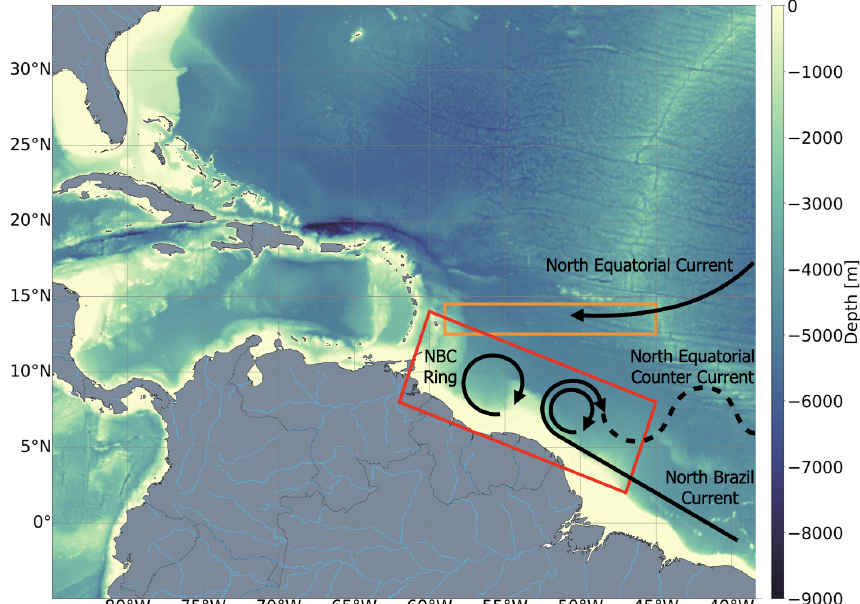
Figure 1. Bathymetric map of the northern Tropical Atlantic Ocean, with the EUREC 4 A-OA/ATOMIC regions of interest framed in orange for the trade wind alley and in red for the eddy boulevard. The main surface currents of these two regions are schematically represented in black. NBC stands for the North Brazil Current.